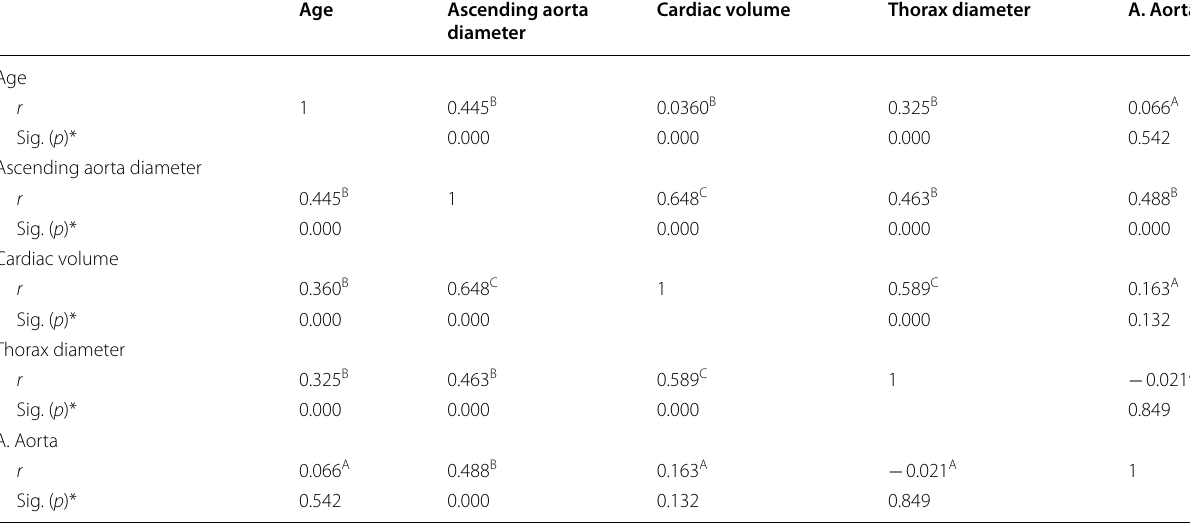
Table 4 Pearson correlations morphologic and demographic variables